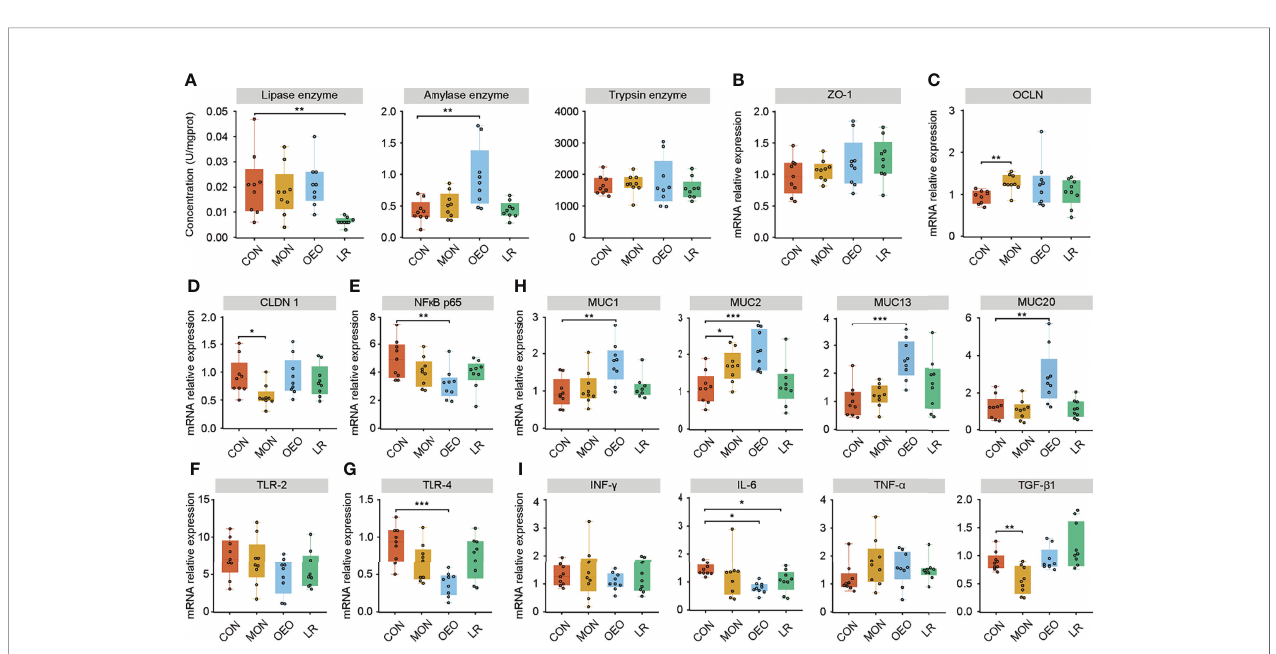
FIGURE 3 | Effect of OEO and LR on the activities of digestive enzymes in ileal contents (A) and relative mRNA expression of genes in jejunal mucosa (B – I) . (B – I) were results of relative mRNA expression of genes related to tight junction proteins, mucin proteins and cytokines. Results are means ± SEM (n = 9/group). CON, a basal diet; MON, a basal diet plus 0.5 g/head/d monensin; OEO, a basal diet with 52 mg/head/d oregano essential oil; LR, a basal diet supplemented with 10 g/ head/d Lactobacillus reuteri. Asterisks indicate signi fi cant difference between the trial group and the CON group (*0.01 < P ≤ 0.05; **0.001 < P ≤ 0.01; *** P ≤ 0.001). ZO-1 , Zonula occludens 1; OCLN , Occluding; CLDN1 , Claudin 1; MUC , Mucin; NF- k B , nuclear transcription factor- k B; TLR , Toll-like receptor; IFN- g , Interferon- g ; IL- 6 , Interleukin-6; TNF- a , Tumor necrosis factor- a ; TGF- b 1 , Transforming growth factor- b